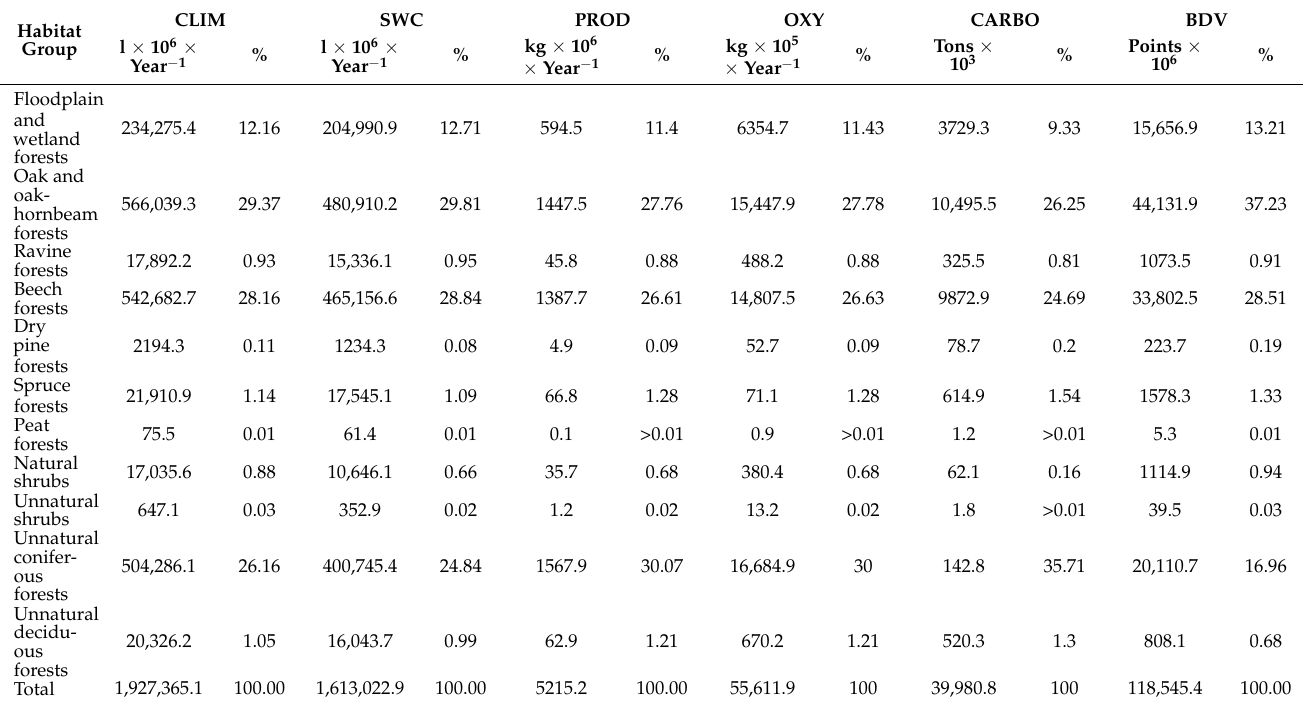
Table 4. The degree of provision of ecosystem functions for the entire area of the territory that was monitored in absolute and relative